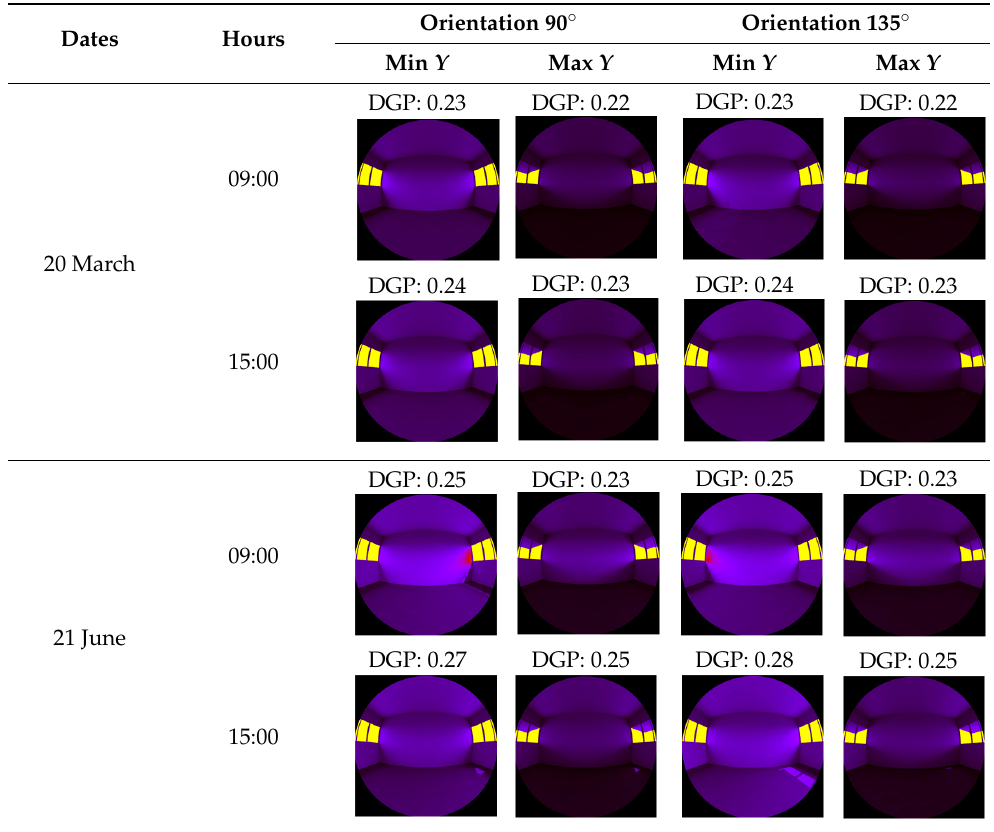
Table 5. DGP values at orientations of 90° and 135° at 09:00 and 15:00 h on 20 March, 21 June, and 21 December *.